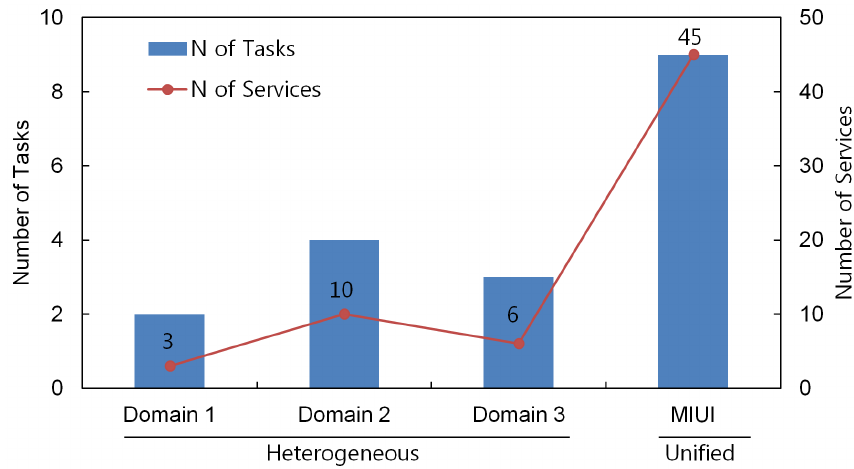
Figure 6. Service availability: Comparison of the number of tasks and services in heterogeneous and MIUI environments.